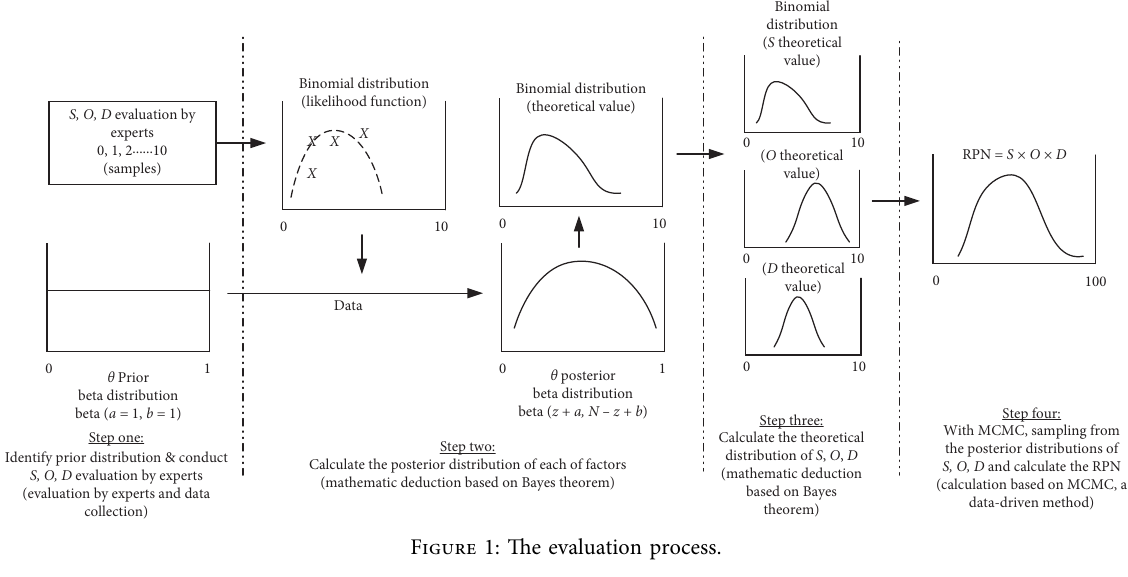
Figure 1: The evaluation process.